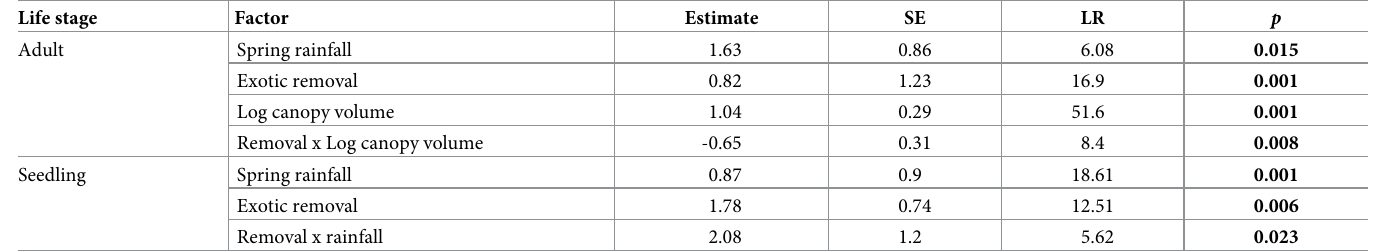
The adult survival model included plant size, as measured by log canopy volume. Columns give the coefficient estimate and standard error determined from 1000 bootstrap replicates, as well as the likelihood ratio test statistic (LR) and p value. Bolded p values indicate results significant at a threshold of <